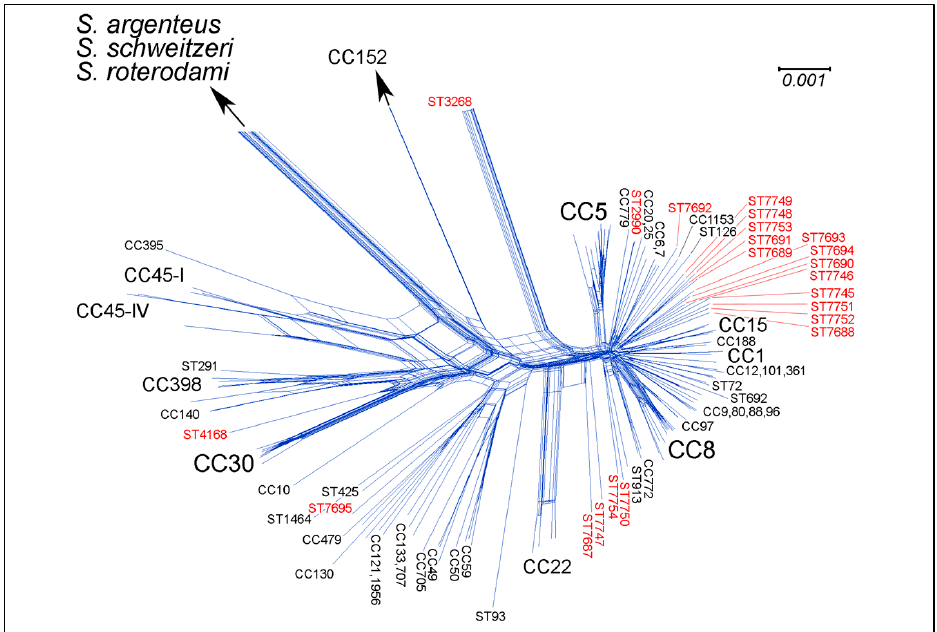
Figure 1. SplitsTree graph [36] based on the sequences of 154 core genomic markers. Study strains are labelled in red. Details on selected sequences and target genes are provided in Supplemental File S3. S. argenteus , S. schweitzeri , and S. roterodami as well as S. aureus CC152 are so “distant” that they cannot be included in a figure at this scale (for their relative positions in a comparable graphic representation, see [37], Figure 1).